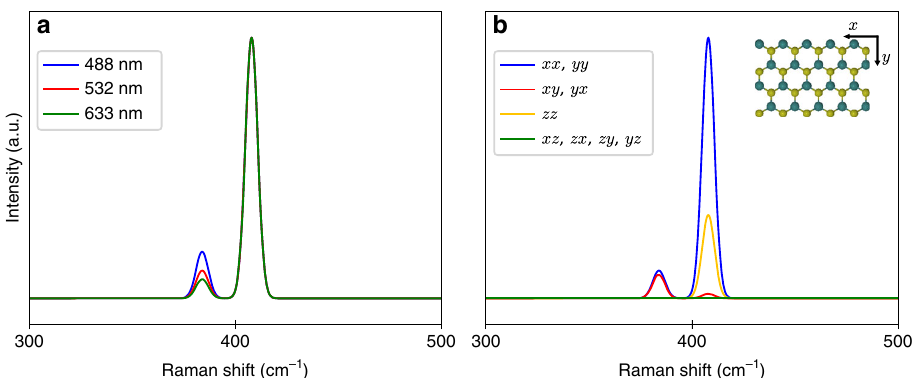
Fig. 4 Polarization and frequency dependent Raman spectra. a Raman spectra of MoS 2 evaluated at three different excitation wavelengths, blue (488 nm), green (532 nm), and red (633 nm) for the xx -polarization setup. b Polarized Raman spectra of MoS 2 for various input and output polarization directions at 532 nm excitation wavelength. The inset shows a top view of the